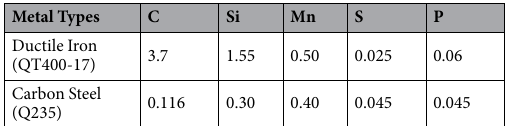
Table 1. Chemical compositions of the ductile iron and carbon steel (wt.%).